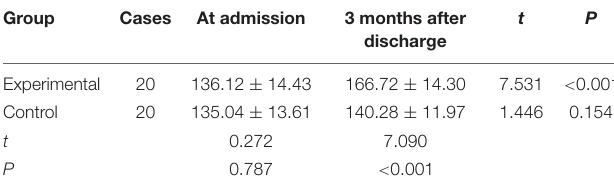
TABLE 3 | Comparison of quality of life scores of two groups of patients with IBD at admission and 3 months after discharge ( (cid:83) x ± P discharge